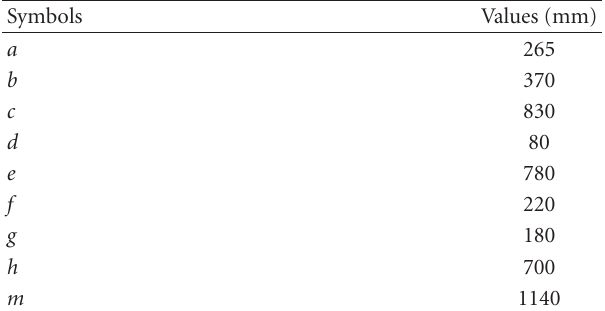
Table 1: Quattro robot geometric and workspace parameters. Symbols